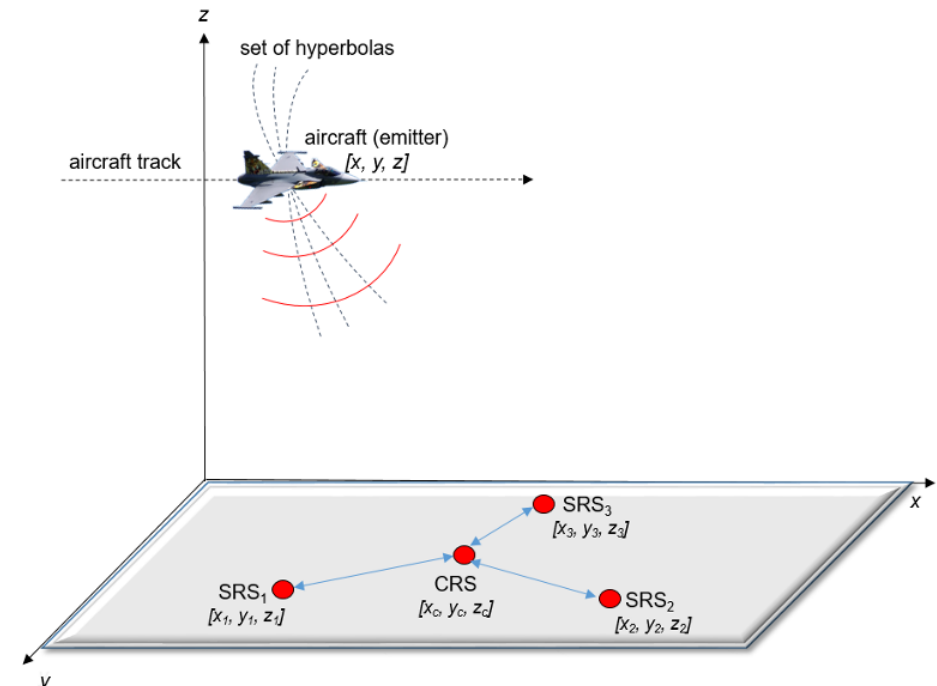
Figure 1. General configuration of the PET TDOA